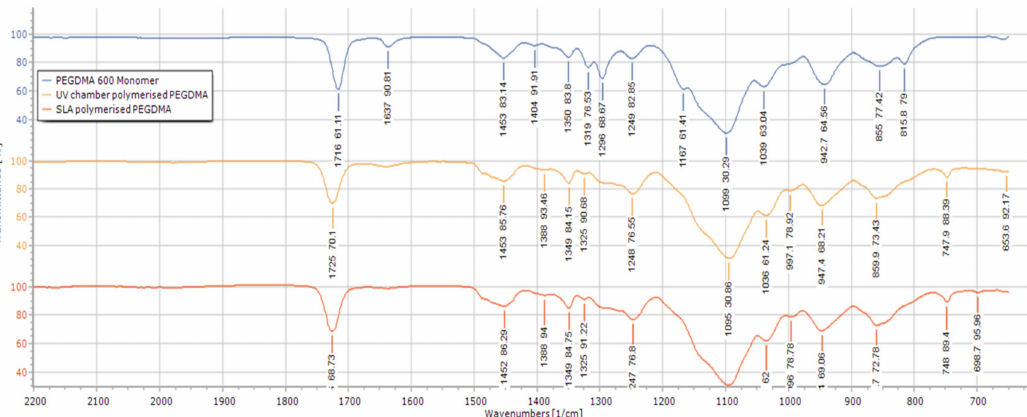
Figure 2. FTIR spectra of the UV chamber-polymerised PEGDMA hydrogels, SLA-polymerised PEGDMA hydrogels and the unpolymerised PEGDMA